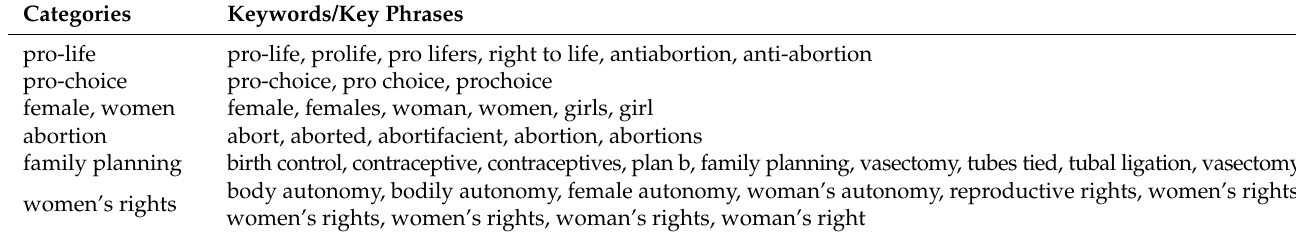
Table A2. Keyword categories.